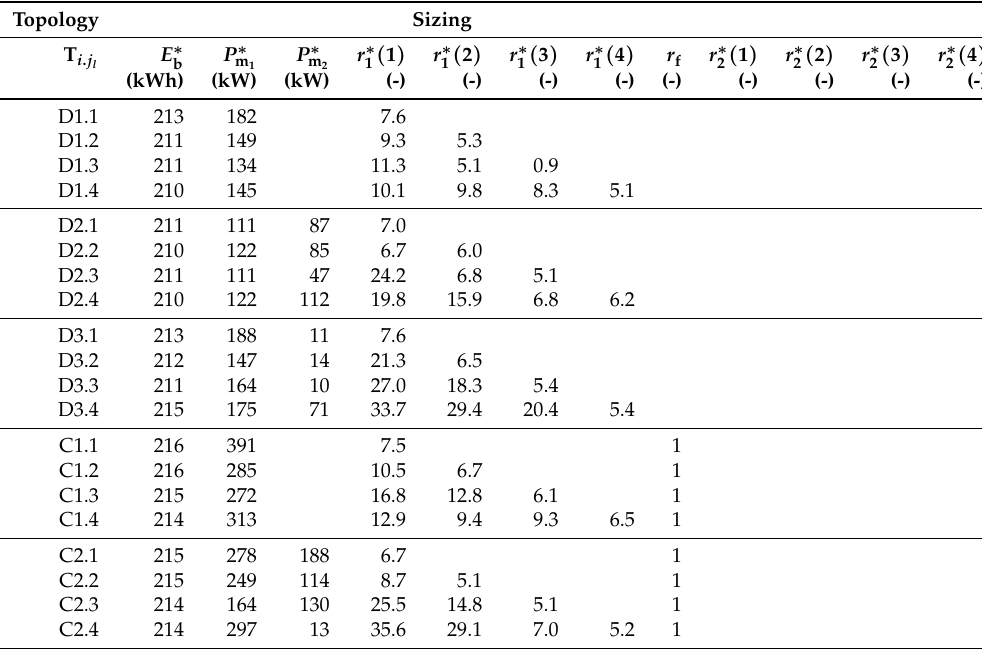
Table A3. Optimal component sizing parameters for the powertrain configurations optimized for total-cost-of-ownership, as discussed in Section